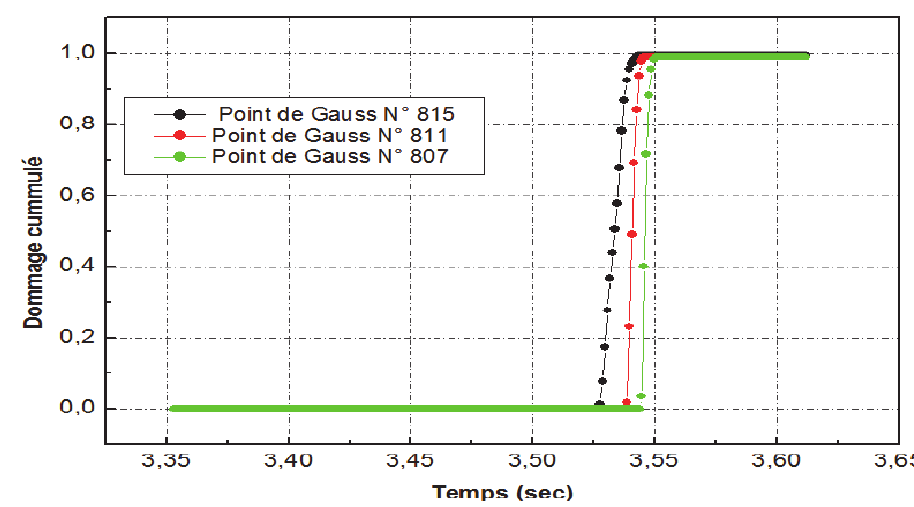
Figure 7: Damage evolution in Gauss